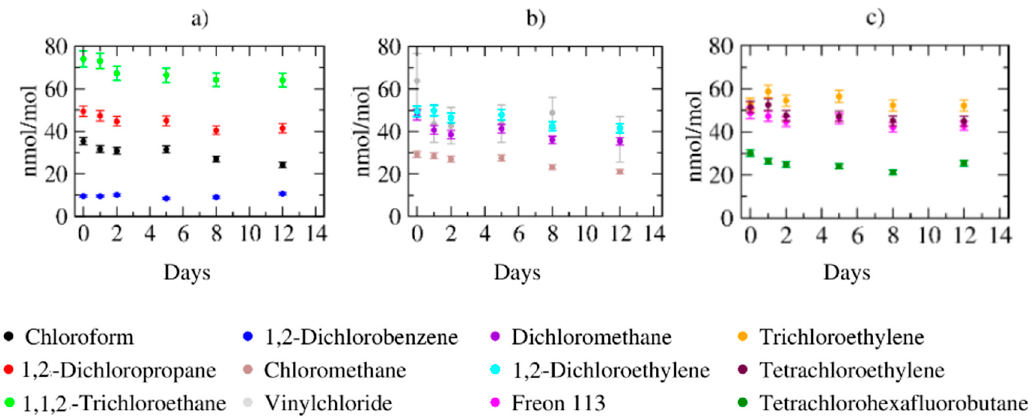
Figure 5. Storage stability of halogenated hydrocarbons on TCC. ( a ) for 1,2-dichlorobenzene, 1,2-dichloropropane, 1,1,2-trichloroethane, chloroform; ( b ) for 1,2-dichloroethylene, vinylchloride, for chloromethane, dichloromethane. ( c ) for tetrachlorohexabutane, trichloroethylene, tetrachloroethylene, freon 113.